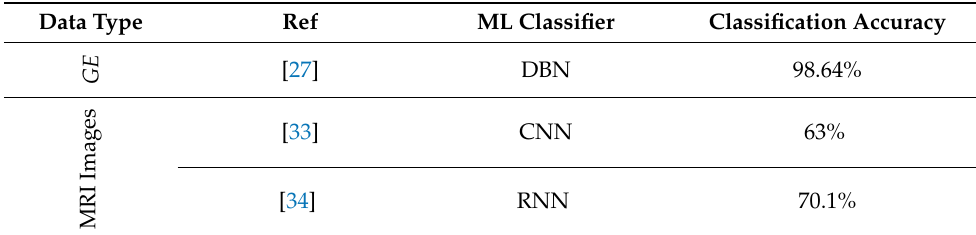
Table 4. ASD prediction using